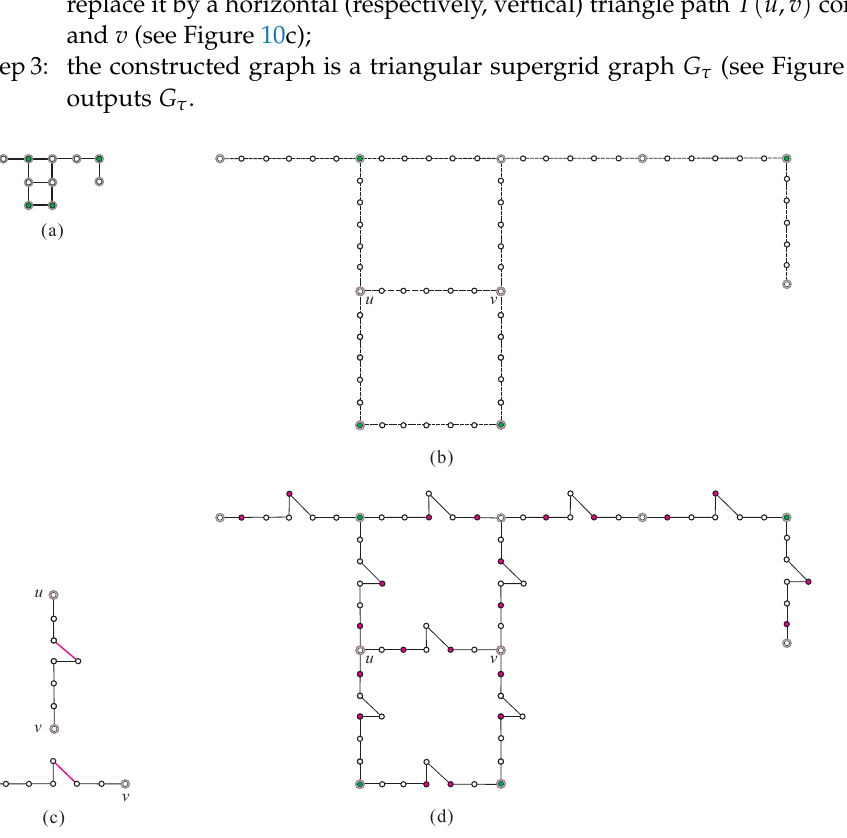
Figure 10. ( a ) A grid graph G g , ( b ) grid graph G (cid:48) g by magnifying each edge of G g by a factor of six, ( c ) (horizontal or vertical) triangle ( u , v ) -path T ( u , v ) , and ( d ) a triangular supergrid graph G τ constructed from G (cid:48) g by replacing each of its enlarged paths with the triangle path in ( c